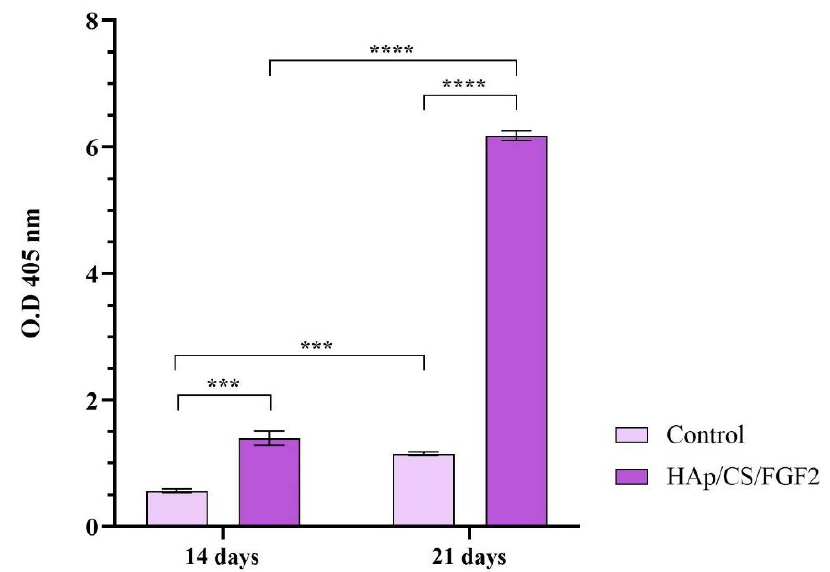
Figure 10. Quantification of the alizarin red S staining after 14 and 21 days of MC3T3-E1 osteogenic differentiation in contact with control samples and HAp/CS/FGF2 coatings (*** p < 0.001; **** p < 0.0001).